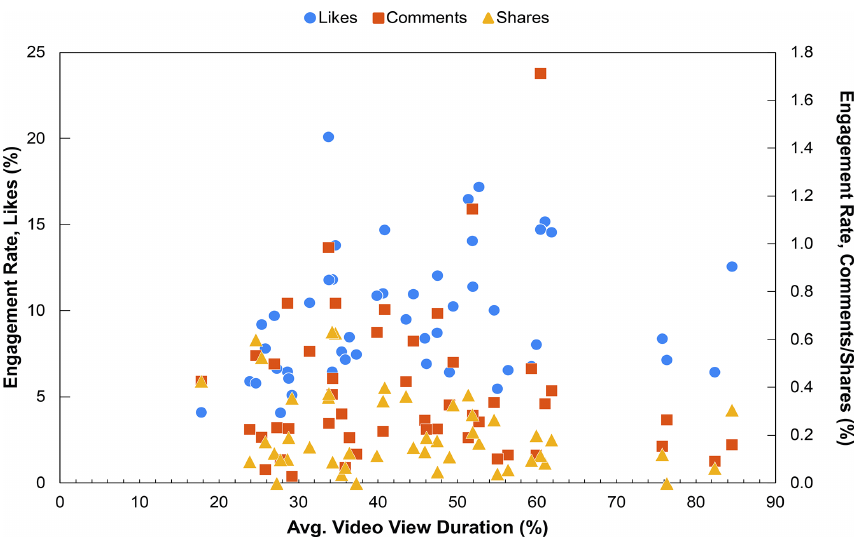
Figure 7. Engagement rates from each video compared with the average view duration (%) of the video. There is no statistically significant correlation with the average view duration and any engagement rate metric ( p > 0.05). See Supplement for full correlation